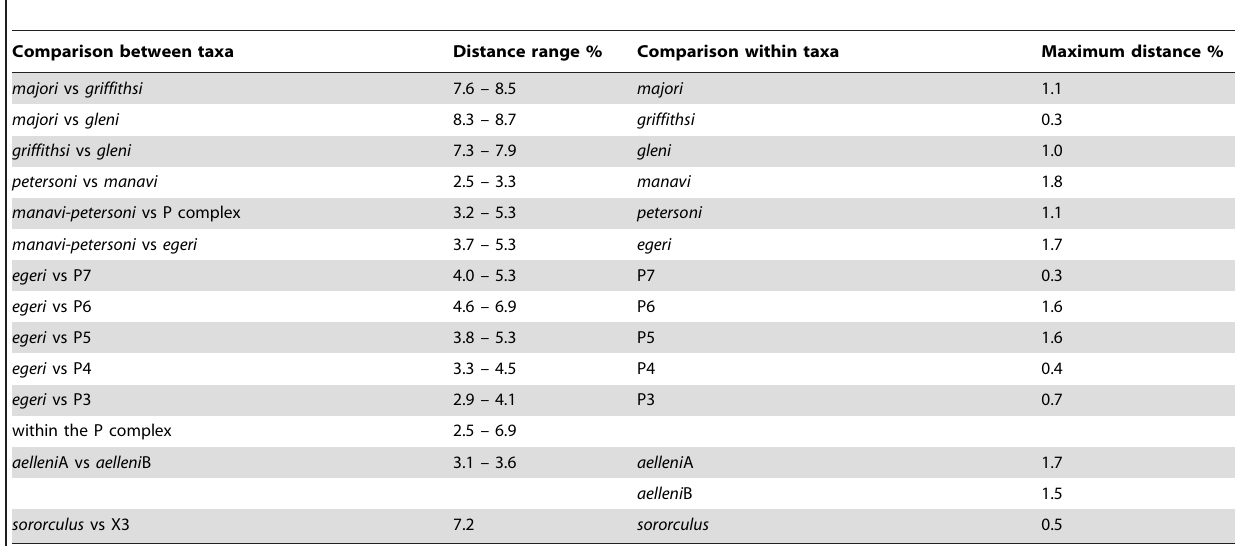
Table 2. mtDNA distances between Malagasy taxa belonging to the genus Miniopterus based on Kimura distances [34].